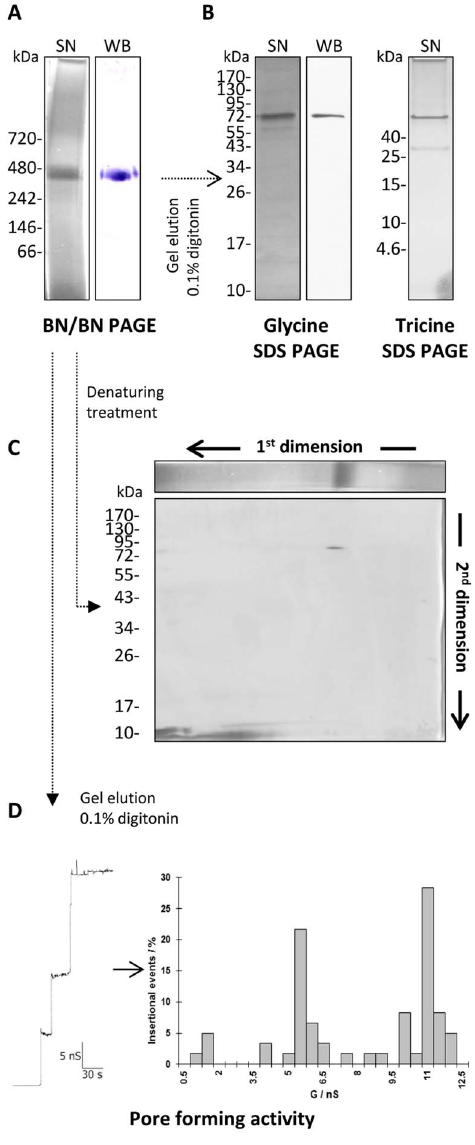
Figure 7. Blue native (BN) PAGE, SDS PAGE and WB analysis of the P66 complex. The complete outer membrane fraction of B. burgdorferi B31 was applied to a 4–16% BN PAGE. A 460 kDa band that reacted to the P66 antibody was extracted from the gel and loaded again in a 4–16% BN PAGE (BN/BN PAGE). This gel was stained with silver nitrate (SN) and subjected to a western blot (WB) against P66 (A). The 460 kDa band was extracted from the gel using detergents and resolved again under denaturing conditions in glycine and tricine SDS PAGE (B). A whole lane from the BN/BN PAGE containing the P66 complex was resolved in a second dimension SDS PAGE (C). The elution of the 460 kDa band from the BN/BN PAGE was tested in planar bilayers for pore-forming activity. Step-like increases in the conductance of the membrane were observed after adding the sample to the salt solution (D, left panel) and at least 100 insertional events were summarized in a histogram (D, right panel).